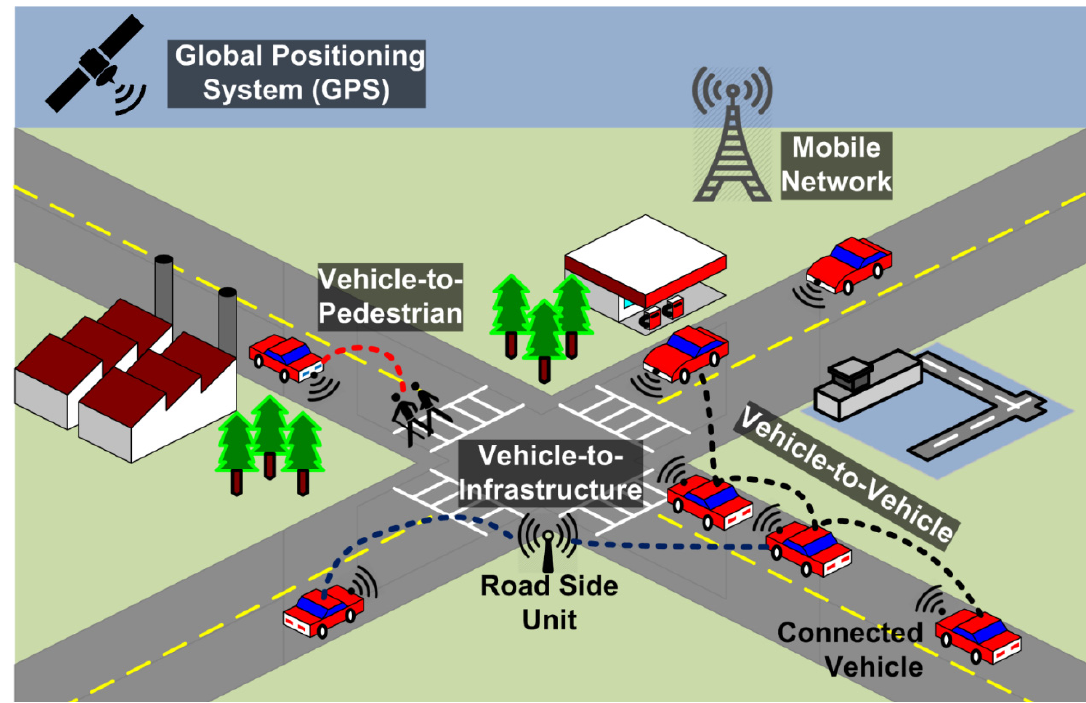
Figure 7. Schematic diagram of CVs in a smart city [88].